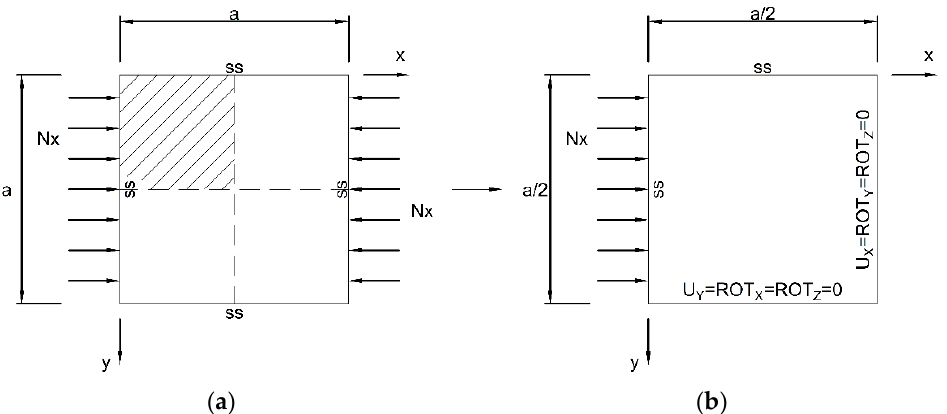
Figure 5. Plate’s entire section model including loads and BCs ( a ) and the plate’s shaded part quarter section model including loads and BCs ( b ).